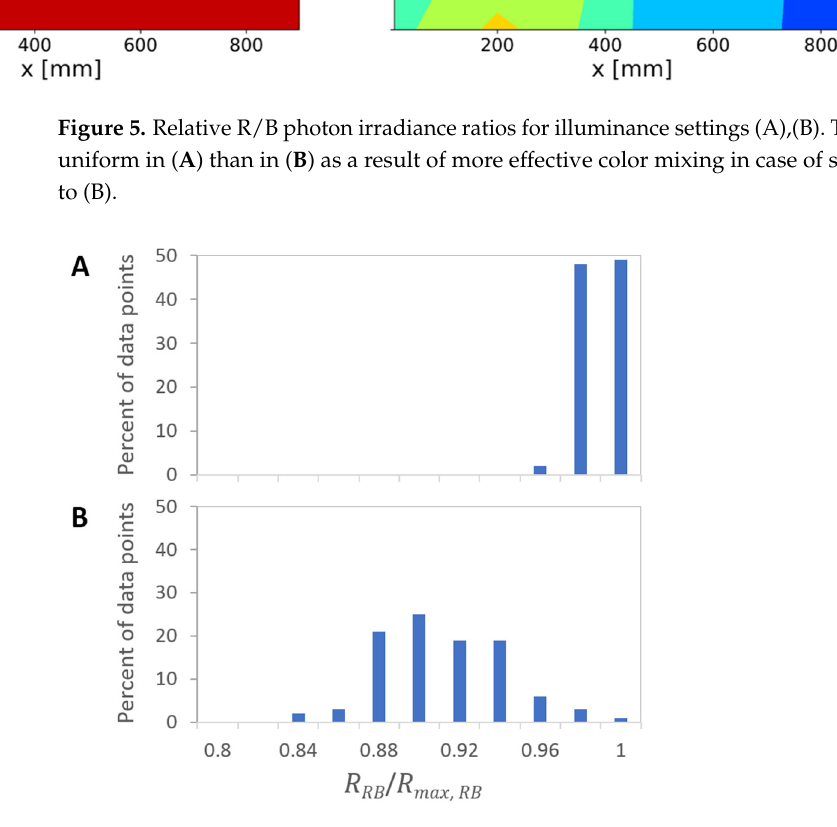
Figure 6. Relative distribution of Red/Blue photon irradiance ratios for illuminance settings (A),(B). RR⁄B values were normalized to the maximum value, R max. The width of the PPFD distribution is narrower in ( A ) compared to ( B ) in line with the contour plots in Figure